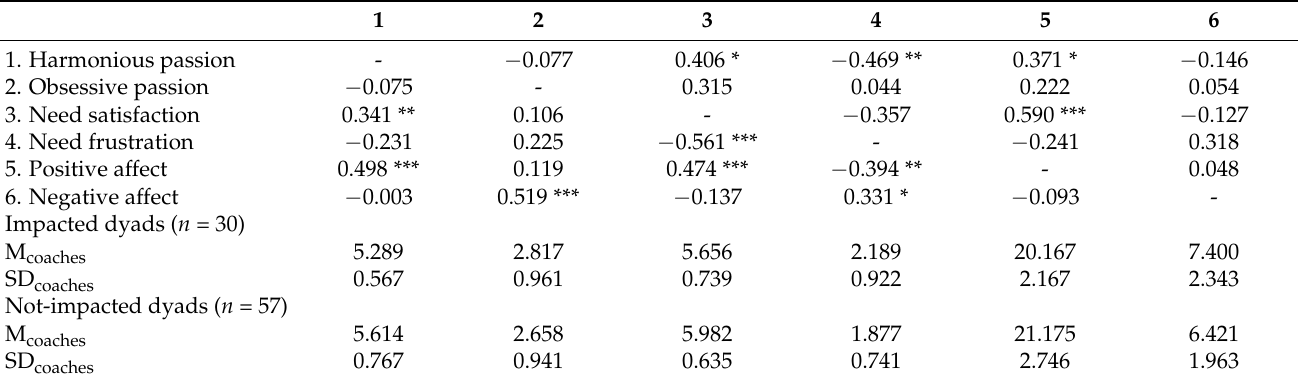
Table 3. Descriptive statistics of and correlations between the coaches’ study